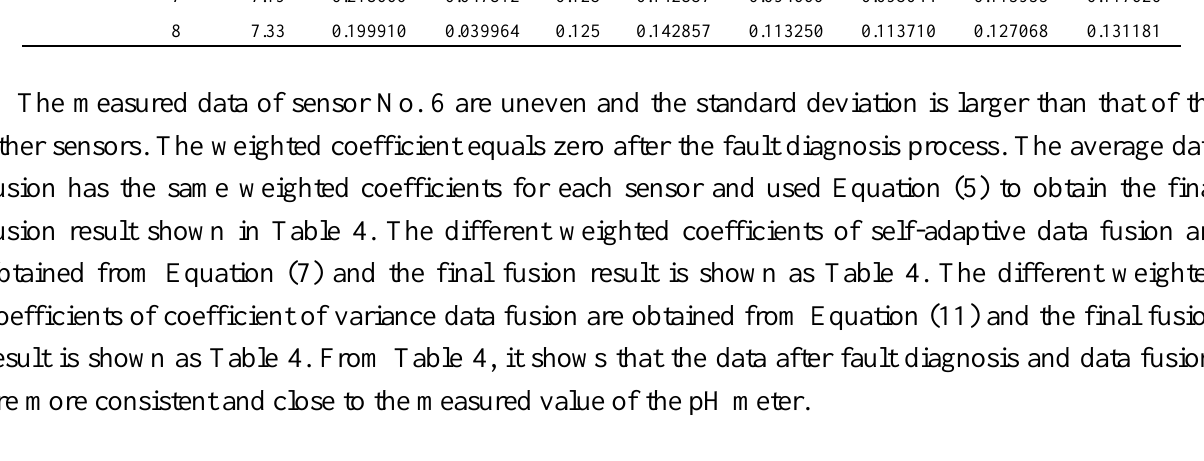
Table 4. Comparison of fusion results of ADF, SADF and CVDF with measured data of grape wine, generic cola drink and bottled water with fault